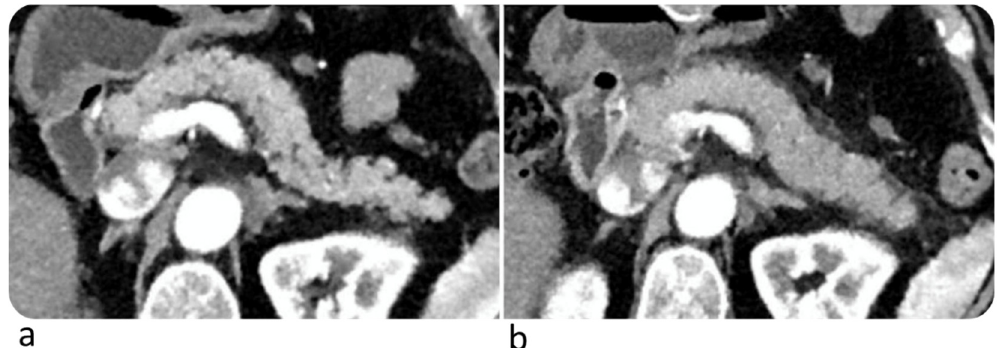
Figure 8. Complicated immune-related pancreatitis in a 61-year-old woman with metastatic melanoma treated with Nivolumab. CT image on arterial phase after 6° Nivolumab showed a normal pancreas ( a ); after 9° Nivolumab (4 months) CT showed a diffuse pancreatic enlargement associated with peripancreatic fat stranding ( b ). The patient was asymptomatic, but the laboratory test demonstrated an increase of lipase and amylase enzymes. © Department of Radiology, Candiolo Cancer Institute—FPO-IRCCs. Turin.